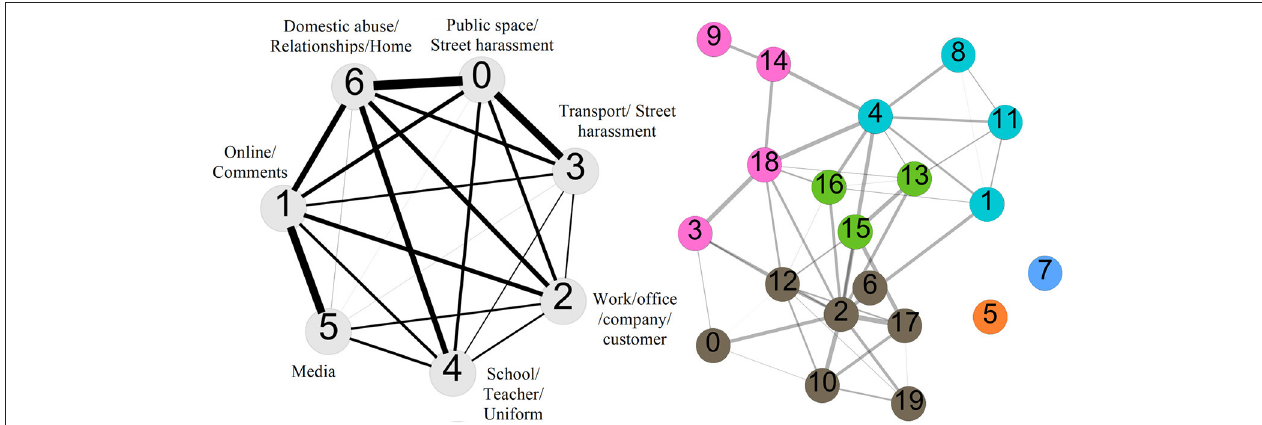
FIGURE 2 | Network visualizations of the topics for n = 7 (Left) and 20 (Right) . The weight of the connections between pairs of the topics is based on the similarity of how the words are assigned to them in the left panel and how topics are assigned in the right panel. We removed connections with cosine similarities smaller than 0.2 for clarity. The color-code of the right panel is based on the communities that are detected using the Gephi implementation of the Leuven algorithm of community detection in networks.